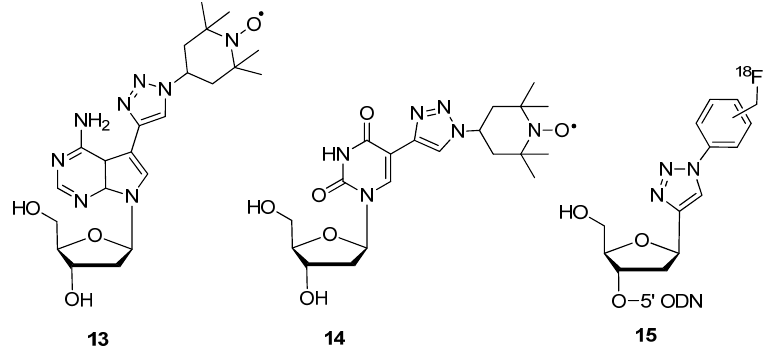
Figure 3. Structures of purine, pyrimidine or nucleobase mimics containing triazole-tethered